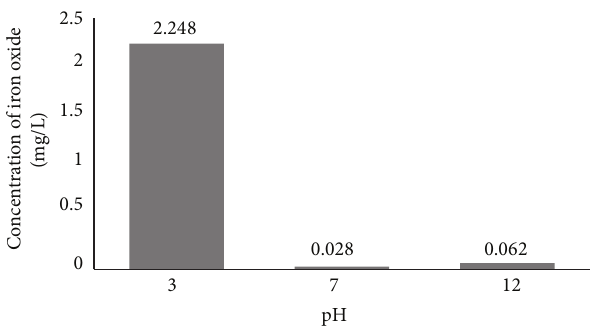
Figure 7: Concentration of leached iron oxide (Fe 3 O 4 ) from magneticcopolymerGN73indifferentmedium(aceticacidsolution (50%, v/v, pH 3.0), phosphate buffer solution (pH 7.0), and sodium citrate/NaOH buffer solution (pH 12.0)) measured by atomic absorption spectrophotometer